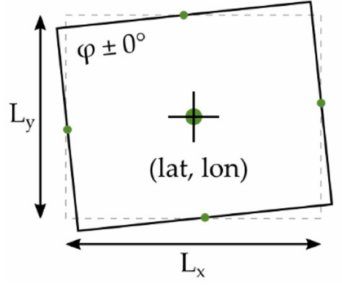
Figure 2. The building façade geometry for solar shading and wind shelter calculations was created from three inputs: length in the x-direction, length in the y-direction (in meter) and building rotation. The latitude and longitude were selected to be the centre-point that the envelope is rotated around.